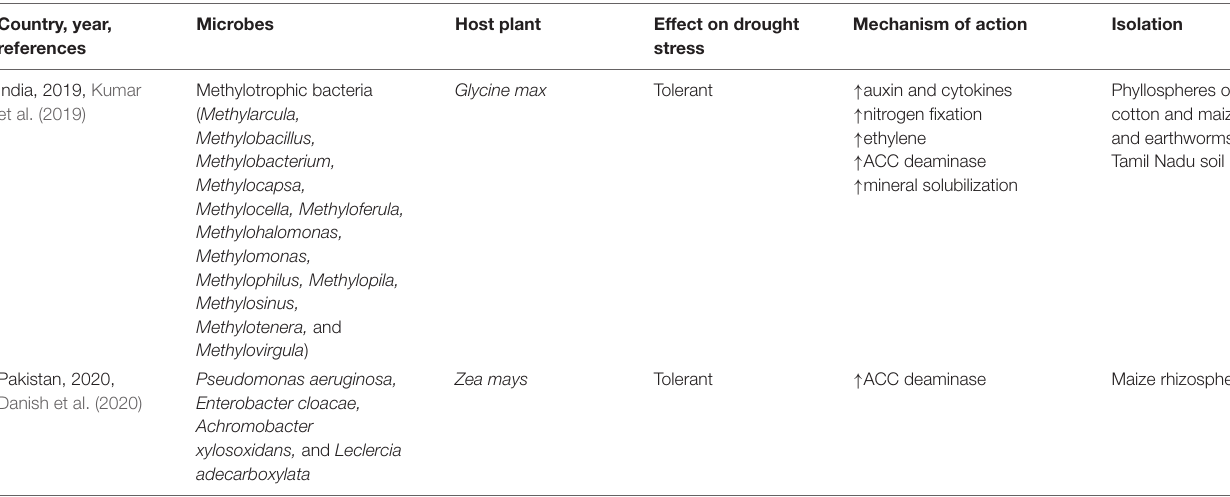
TABLE 5 | Methanotrophs mitigate drought